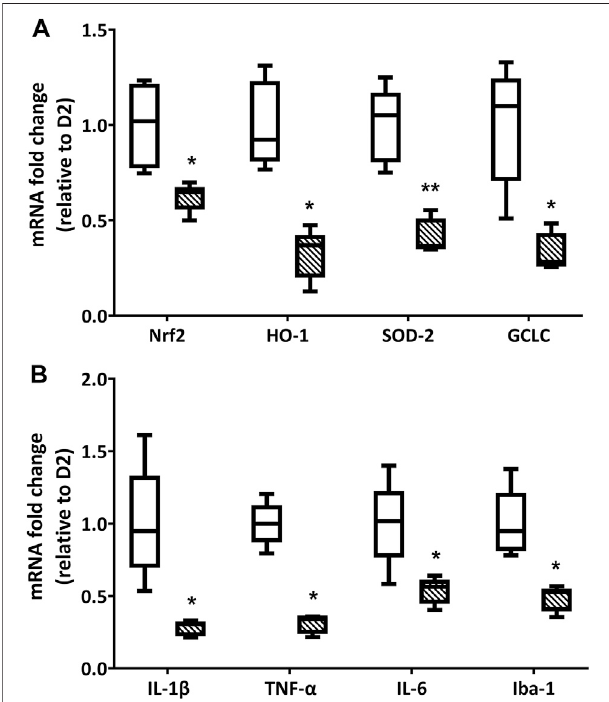
FIGURE 3 | Endpoint qPCR analysis for the expression of oxidative stress (A) and in fl ammation-related (B) markers in D2 (white box) and D2+LG (dashed boxes) groups after 2 mo of treatment. Box plots describe the statistical distribution of n (cid:1) 6 independent retinas. Differences between groups were tested using two-tailed t -test. * p < 0.05, ** p < 0.01 vs D2.